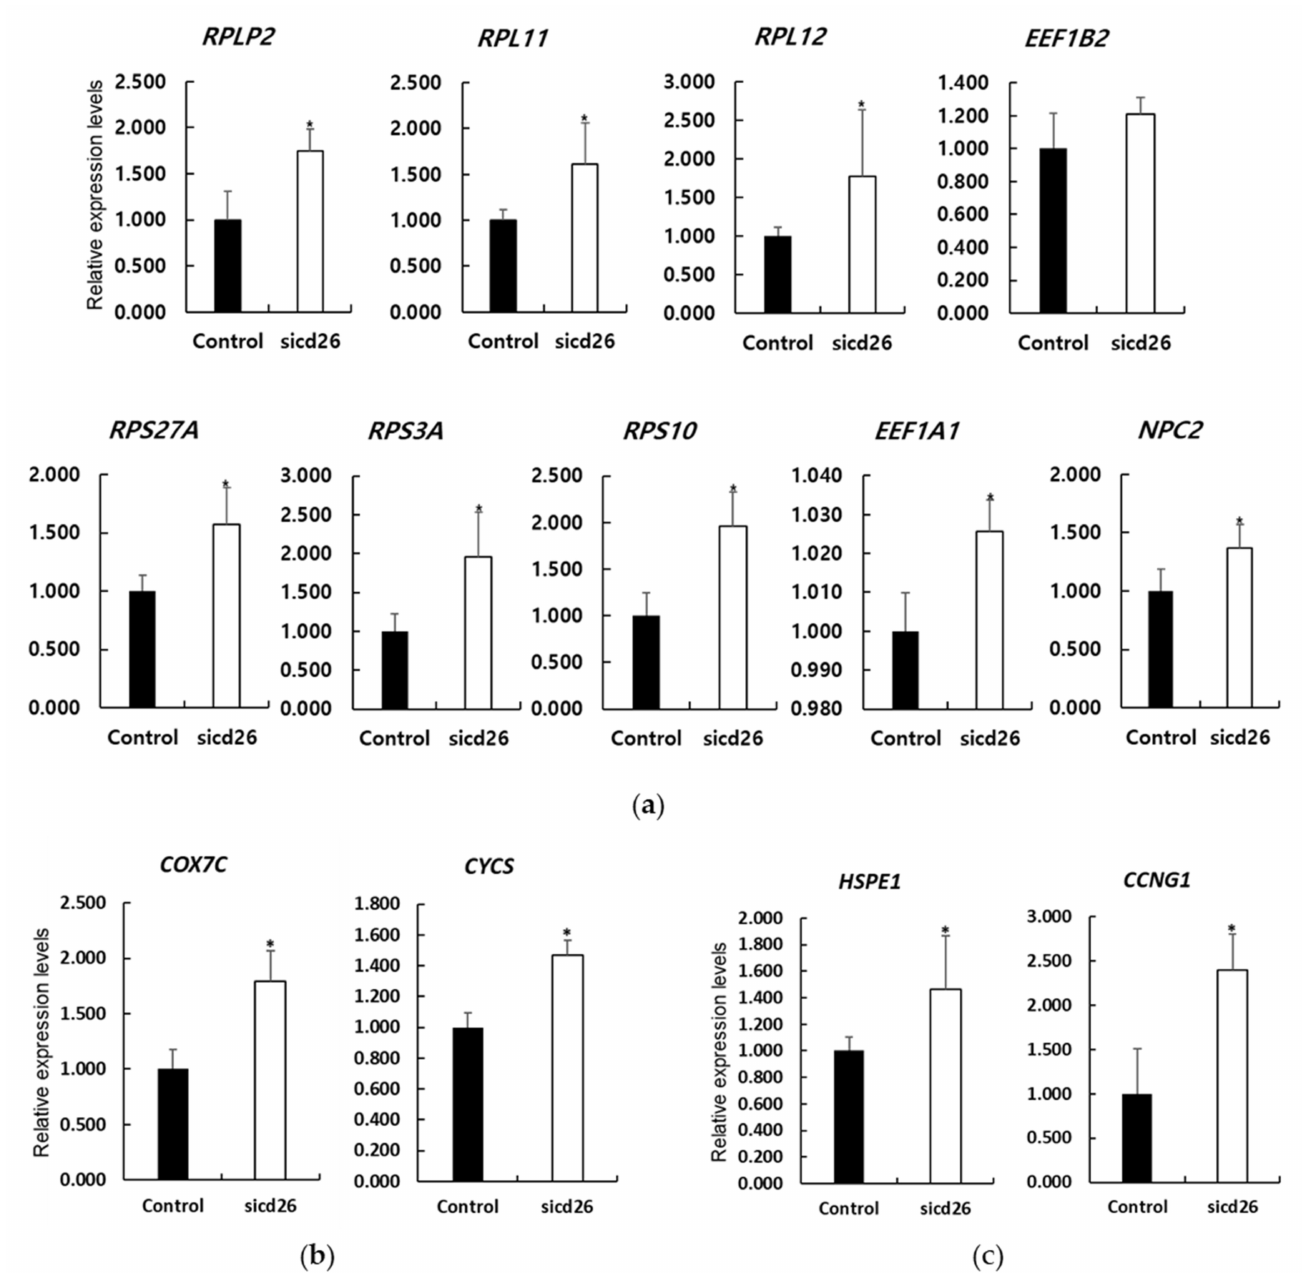
Figure 3. Comparison of mRNA expression levels of ribosomal protein ( a ); reactive oxygen species- ( b ); and apoptosis-related ( c ) genes in the control groups and cd26-siRNA-injected embryos. Bars represent mean ± SEM of three independent experiments; the results were analyzed using the one-way ANOVA. * p < 0.05 versus